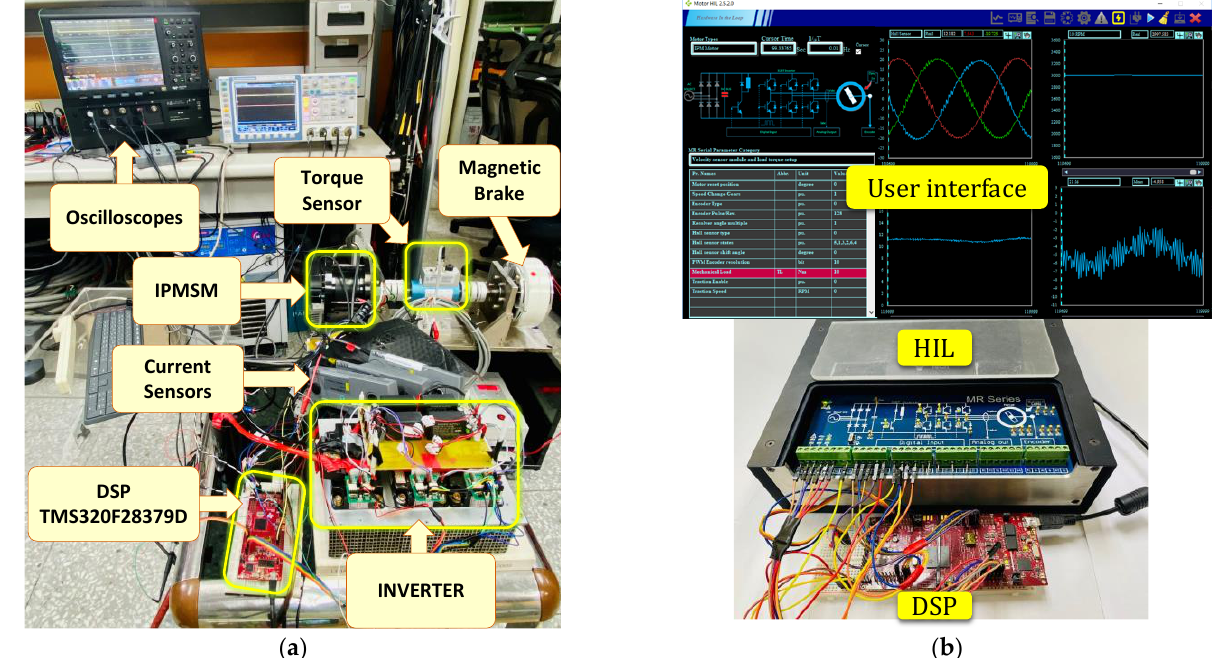
Figure 5. ( a ) IPMSM drive test platform and ( b ) hardware-in-the loop toolkit for testing PMSM control. Table 1. Target IPMSM specifications.